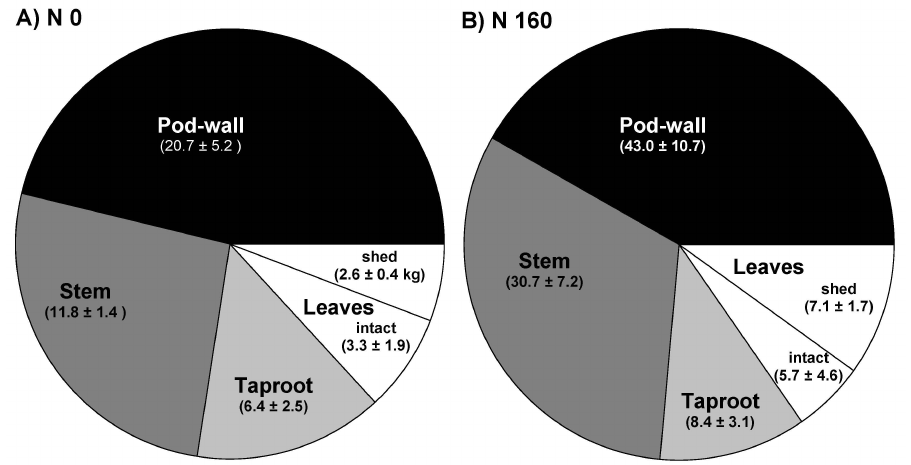
Figure 10. Amount of N (kg N ¨ ha ´ 1 ˘ SD) and distribution among plant parts in the crop residues at maturity ( A ) without N (N0) and ( B ) at optimal N fertilization (N160). The data are shown across the winter oilseed-rape line-cultivars Apex and Capitol ( n =